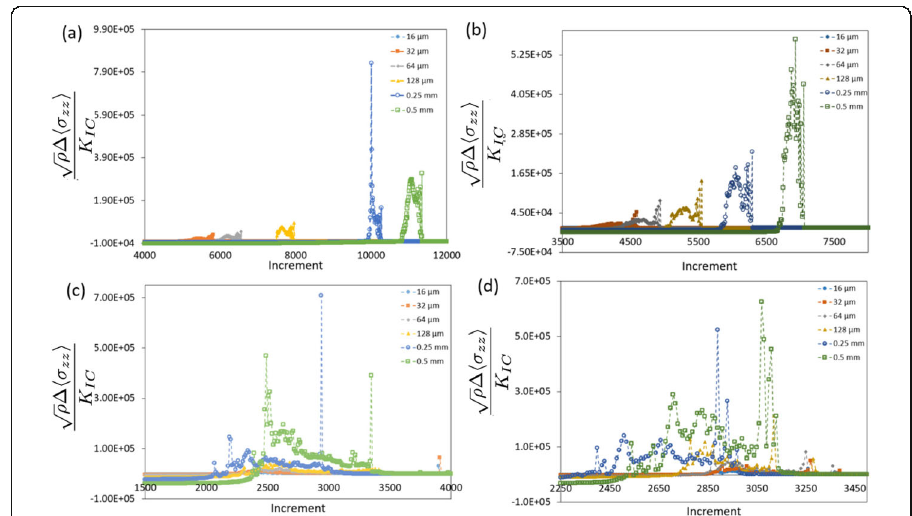
Fig. 13 Dimensionless, instantaneous rate of change of the average stress: The dimensionless term for the instantaneous rate of change of average stress of system sizes L x = 8 μ m, L y = 0.25 mm, and L z = 1.0 mm where D = 2.995 as a function of the incremental step with respect to R G where ( a ) has a R G = 0.0, ( b ) has a R G = 0.1, ( c ) has a R G = 0.2, and ( d ) has a R G = 0.4. . The figure legends signify the notch width W that varies from 0.5 to 128 μ m